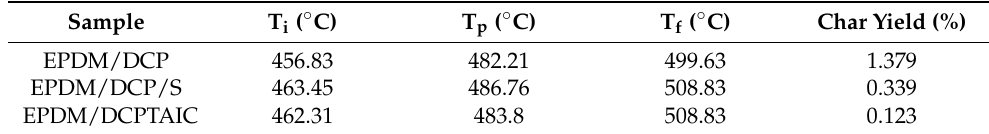
Figure 7. SEM images of CFRP/EPDM composite cross-sections. ( a ) CFRP/EPDM/DCP, 160 °C, 20 min. ( b ) CFRP/EPDM/DCP/S, 160 °C, 20 min. ( c ) CFRP/EPDM/DCP/TAIC, 160 °C, 20 min. ( d ) CFRP/EPDM/DCP, 160 °C, 30 min. ( e ) CFRP/EPDM/DCP/S, 160 °C, 30 min. ( f ) CFRP/EPDM/DCP/TAIC, 160 °C, 30 min. ( g ) CFRP/EPDM/DCP, 160 °C, 40 min. ( h ) CFRP/EPDM/DCP/S, 160 °C, 40 min. ( i ) CFRP/EPDM/DCP/TAIC, 160 °C, 40 min. Table 3. The TGA results of EPDM